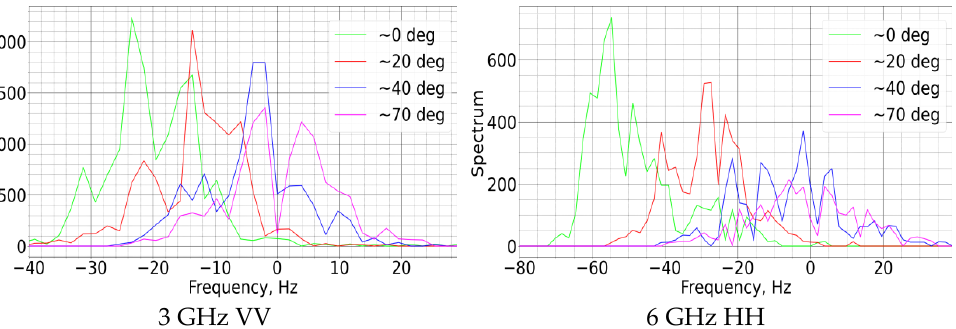
Figure 8. Some examples of the Doppler spectra of radar backscatter at different azimuth angles. Oceanographic Platform, the Black Sea.